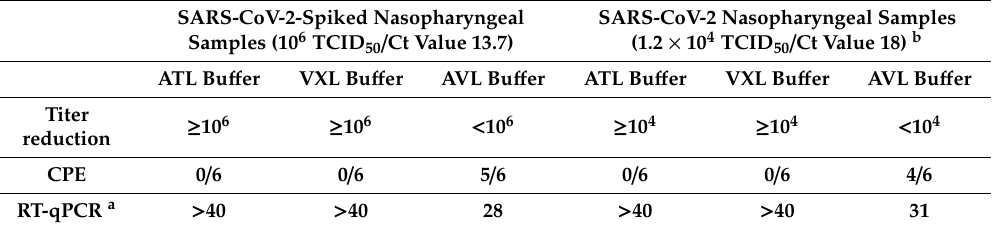
Table 3. Inactivation of SARS CoV-2 positive nasopharyngeal samples using three lysis bu ff